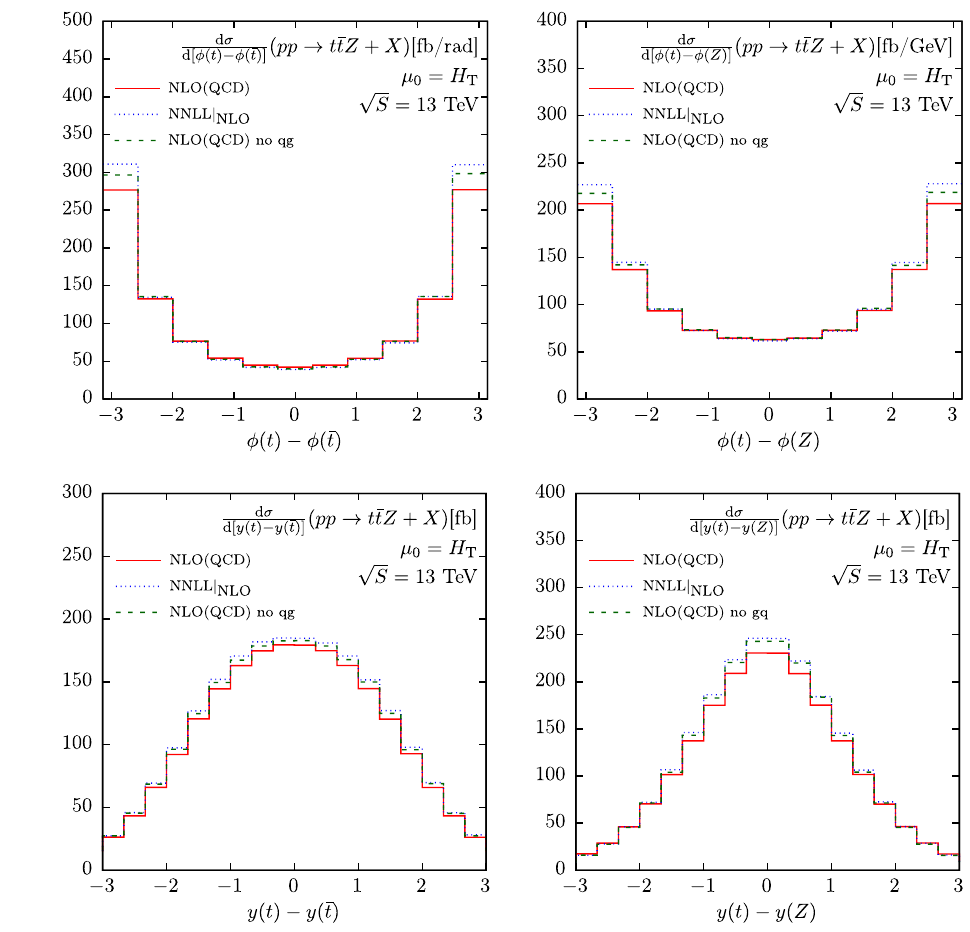
Fig. 4 The same as in Fig. 2 but for the pp → t ¯ tZ